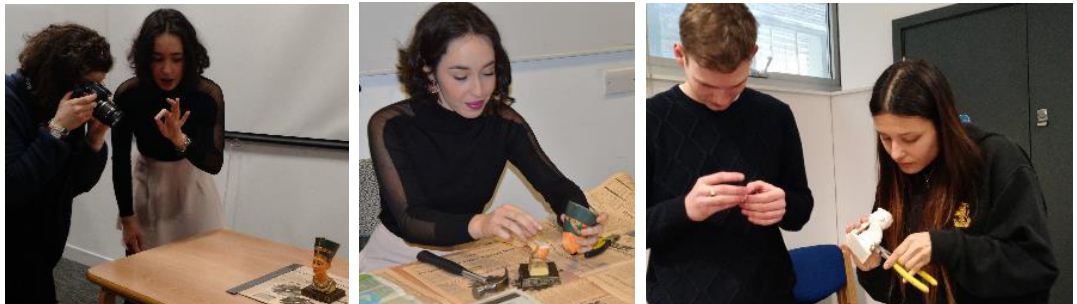
Figure 2. Student in classroom: Photographing the object towards a photogrammetric reconstruction (left), intentionally destroying a replica object Nefertiti (centre), cleaning a 3D print of a portrait bust of the student on the left (right), in